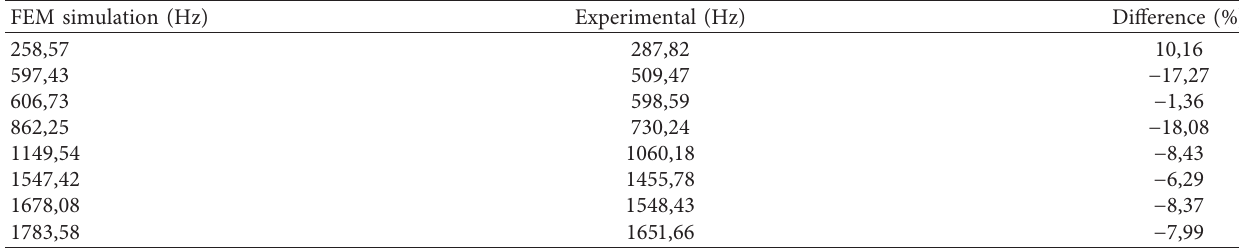
Table 18: Comparison of FEM and experimental frequencies (Case 4).